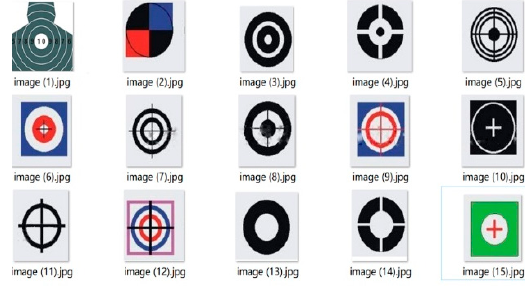
Figure 17. Target positive specimen training set.